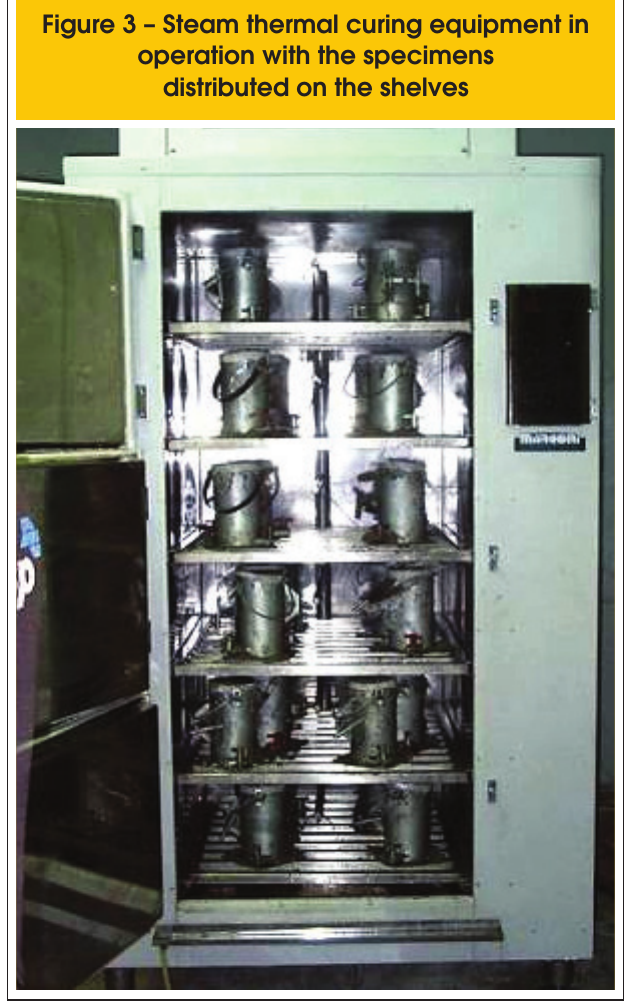
Figure 3 – Steam thermal curing equipment